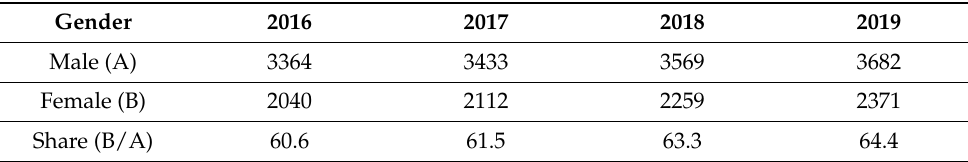
Table 4. Monthly gross income by gender. Unit: KRW 1000,